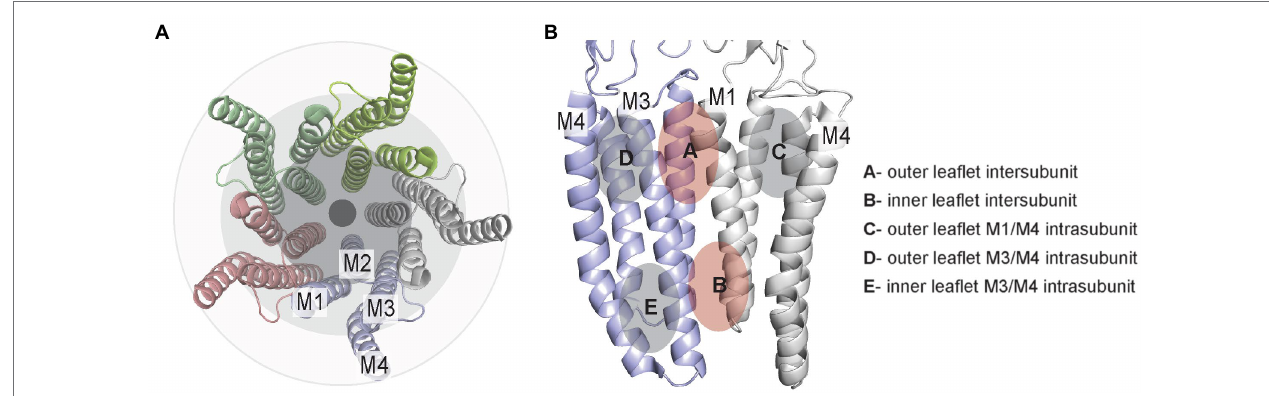
FIGURE 1 | TMD lipid-drug binding sites in pLGICs illustrated using the GLIC structure (pdb 4hfi). (A) Top/extracellular view of the TMD helices showing the 3-ring organization. (B) Two adjacent TMD subunits illustrating the general location of inter- and intrasubunit sites in the outer and inner